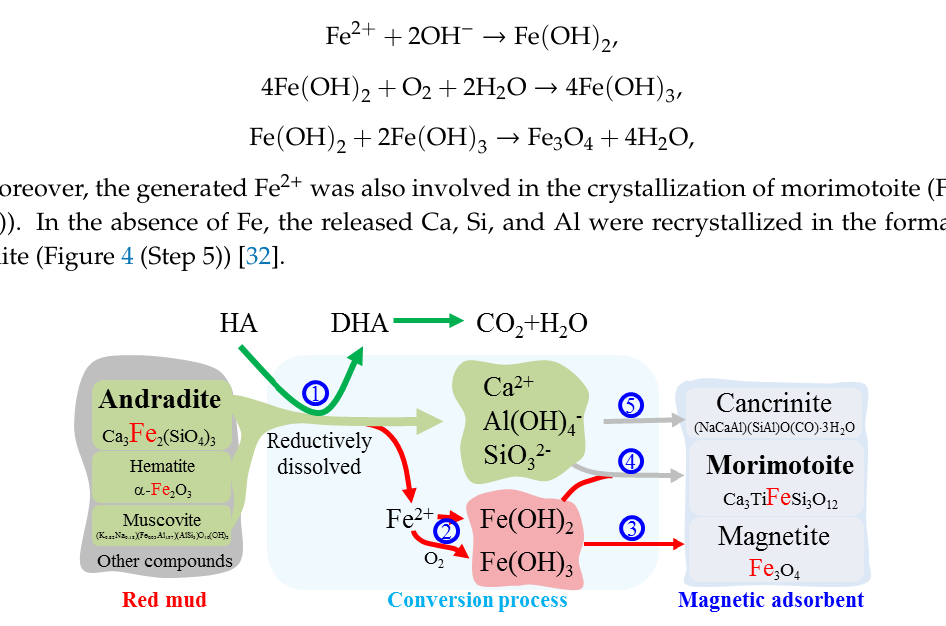
Figure 3. ( A ) Composition of red mud, P-120, P-200, and P-270, and ( B ) the major cationic concentrations in the supernatant after hydrothermal treatment.